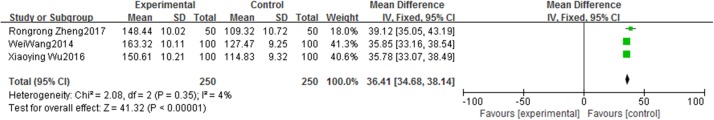
Forest plot diagram showing Self-care ability of patients with PICC after discharge in WeChat group and traditional group.Each square indicates a study, and the area of squares is proportional to the weight of the study. The diamond represents the summary MD and 95% CI. CI = confidence interval, MD = mean difference.